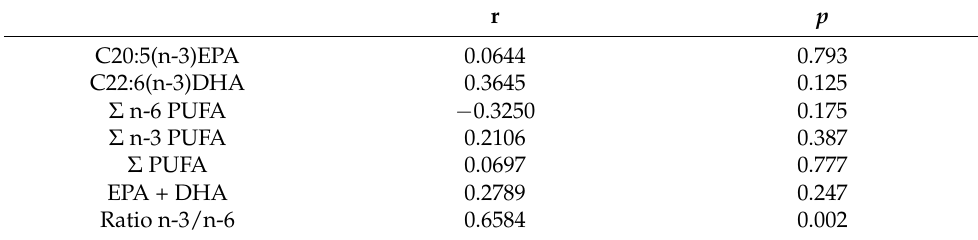
Table 6. Linear correlation coefficients (r) between fatty acids (expressed as mg/g fish muscles) in the muscles of eels ( Anguilla anguilla L.) and total mercury, expressed as µ g/g wet